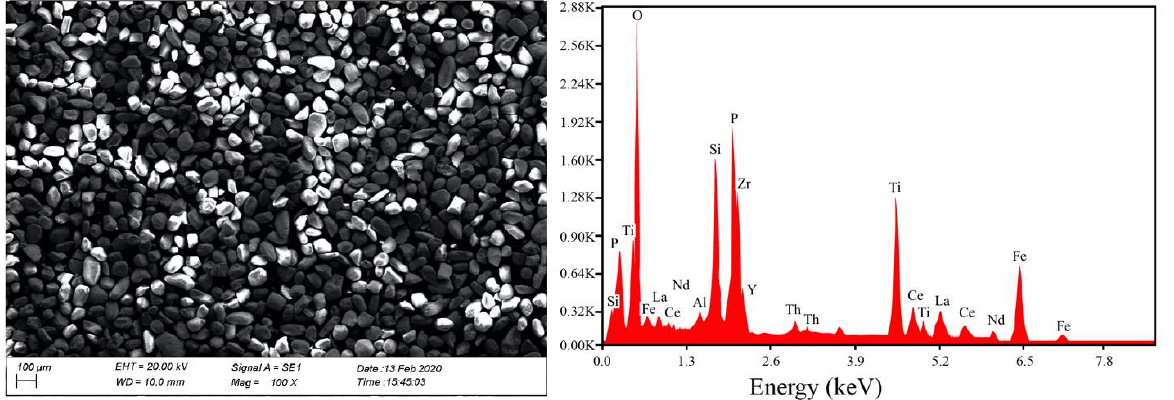
Figure 8. SEM/EDX spot analysis of the concentrate.